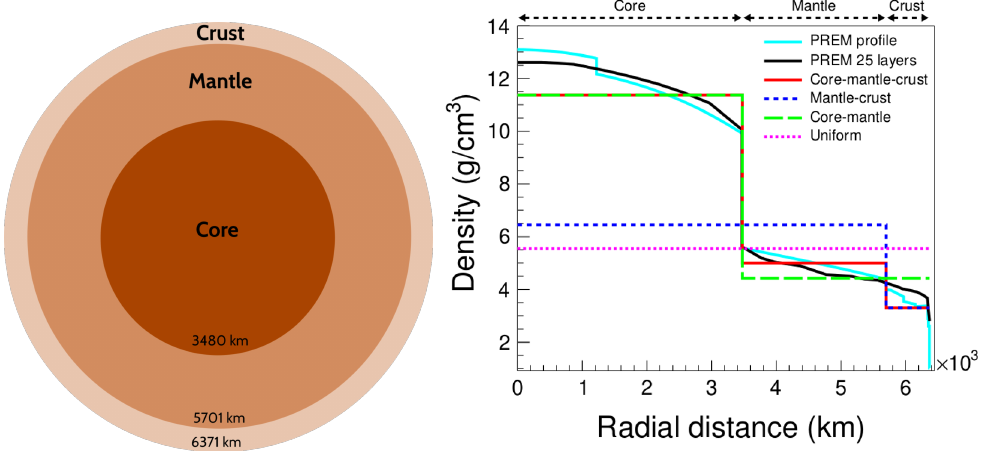
Figure 1 . Left: three-layered profile of Earth. Right: density distribution of profiles of Earth as a function of radial distance from the center of Earth. Note that the total mass of the Earth is the same in all the profiles.